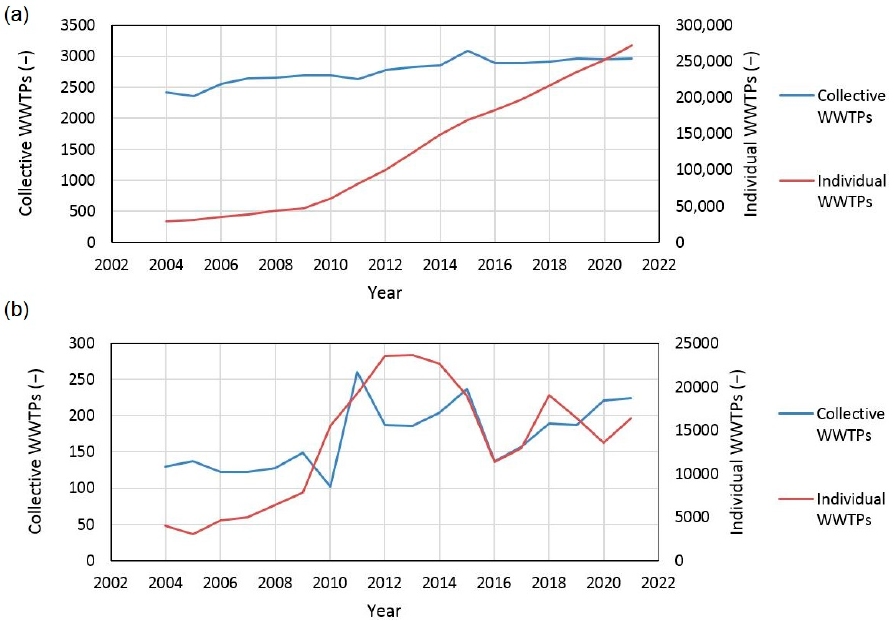
Figure 8. Development of rural wastewater treatment plants in 2004–20201, data obtained from [66]: ( a ) number of collective and individual rural wastewater treatment plants, ( b ) annual number of constructed collective and individual rural wastewater treatment plants.